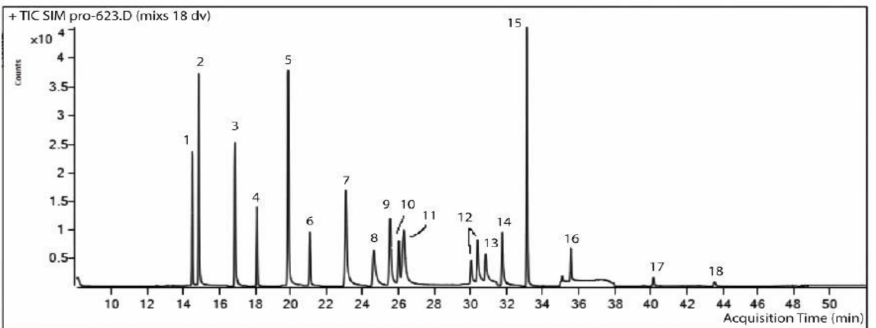
Figure 2. Chromatogram of the model solution of 18 pesticides with the concentration of 0.1 µ g · ml − 1 . The Selected Ion Mode (SIM): 1—diazinon, 2—chlorothalonil, 3—mefenoxam,